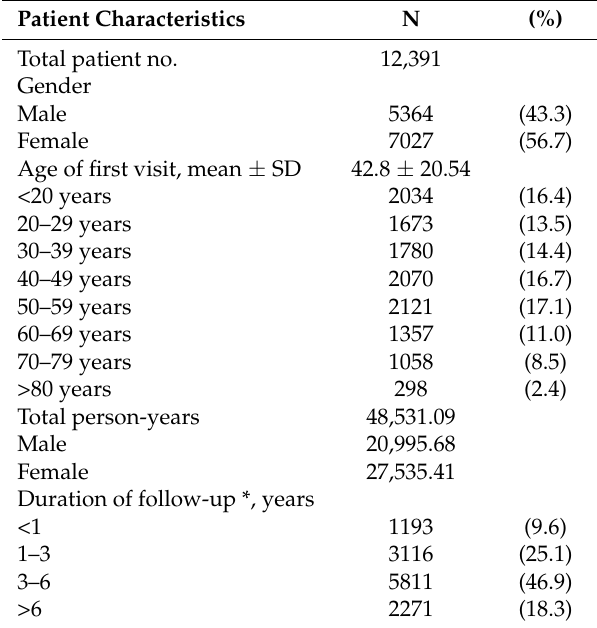
Table 1. Characteristics of vitiligo